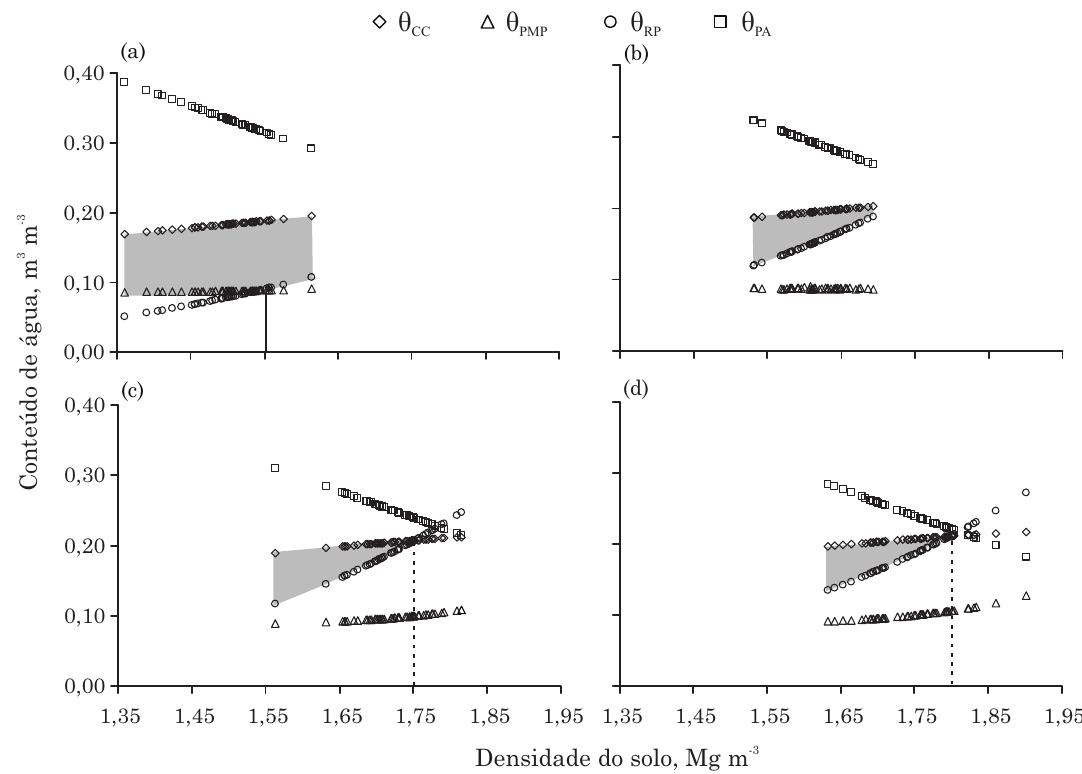
Figura 2. Variação do conteúdo de água ( θ)θ)θ)θ)θ) em função da densidade do solo na capacidade de campo ( θθθθθ CC = -100 hPa), ponto de murcha permanente ( θθθθθ PMP = -15.000 hPa), porosidade de aeração ( θθθθθ PA = 0,10 m 3 m -3 ) e resistência do solo à penetração ( θθθθθ RP = 2 MPa) para os tratamentos mata nativa (a), pastagem (b), citros (c) e cultivo (d). A área hachurada indica o intervalo hídrico ótimo (IHO); as linhas pontilhadas, a Ds c (IHO = 0); e a linha sólida, a Ds a